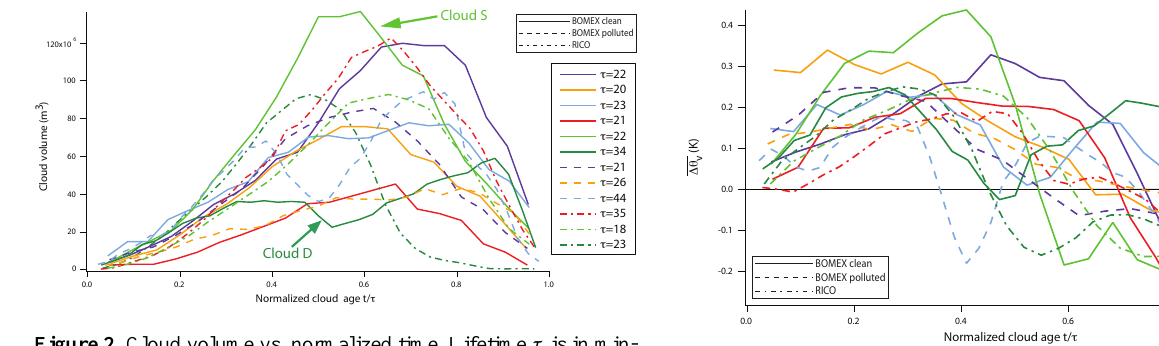
Figure 4. Scatter plot of volume-averaged 1θ v and d V